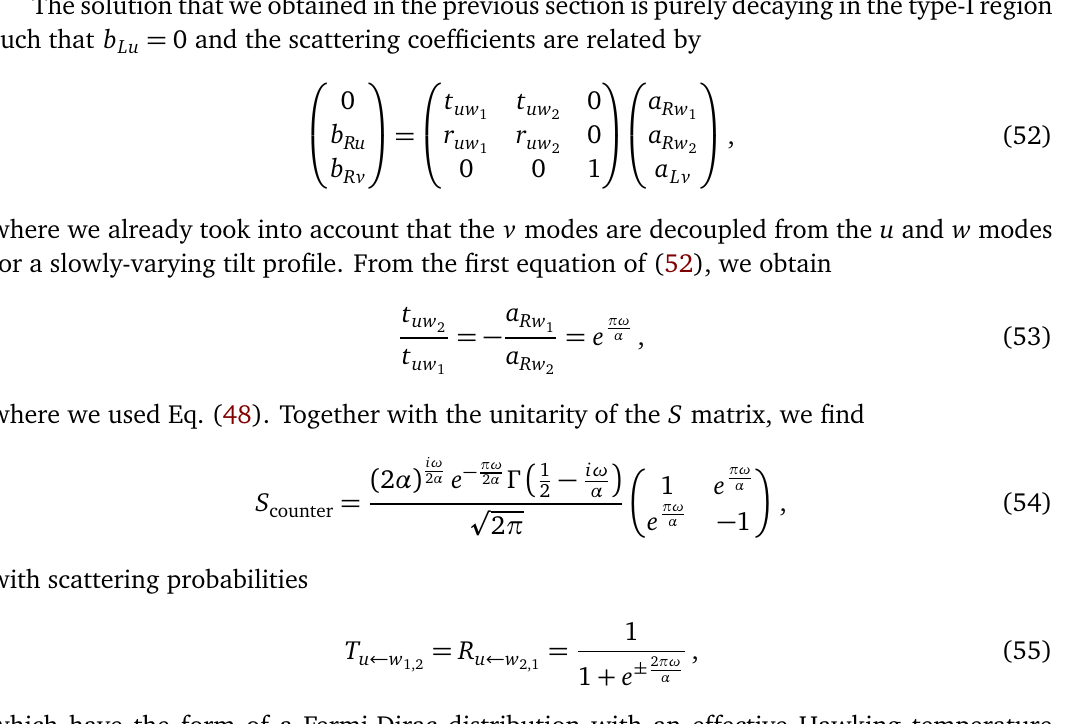
Figure 3: Real and imaginary part of the second spinor component ψ zero transmission outside of the horizon and the tilt profile V ( z ) = 1 + tanh ( α z ) with α = 0.1 and ω = 0.05. Solid curves give the exact solution, while the circles and crosses give the WKB solutions and the approximate solution near the linear horizon, respectively. The vertical dotted line marks the classical turning